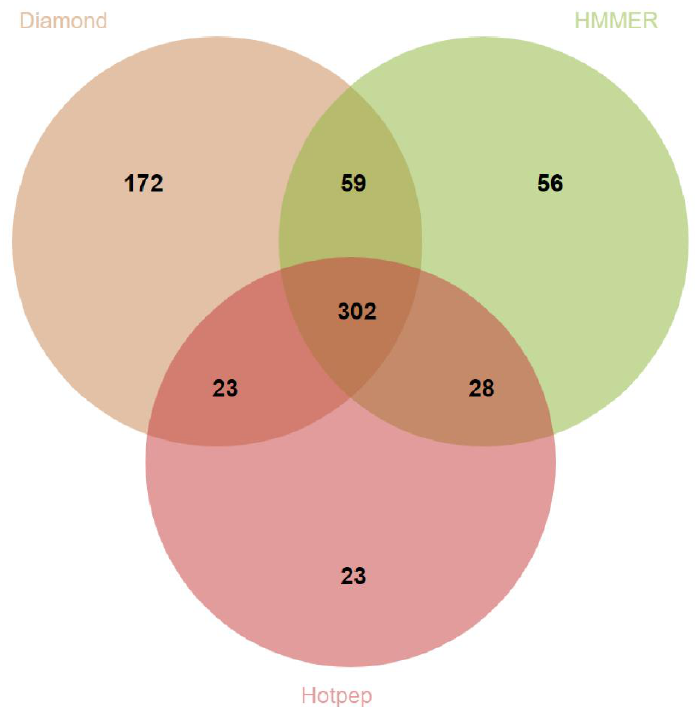
Figure 2. Venn diagram showing overlaps among the annotation results in T. hamatum FBL 587 for multi-domain CAZymes of three different tools: (1) HMMER, (2) DIAMOND, (3) Hotpep (see text). With respect to genes involved in the formation of SMs, a class of genes of relevance to mycoremediation, in FBL 587 a genomic repository of potential SMs driven by non- ribosomal peptide synthases (NRPS), polyketide synthases (PKS), hybrids NRPS-PKS and terpene was surveyed. Using the tool antiSMASH, version 6.0.0 (see [29]), we identified a relatively few number (27) of candidate BGCs for the production of SMs in T. hamatum FBL 587 (Table 2; Supplementary Table S6). Most of the antiSMASH-6.0-detected gene clusters cannot be annotated as their composition is not similar to any known fungal BGC (Supplementary Table S6). In T. hamatum FBL 587, we identified 8 PKS, 4 NRPS, 4 NRPS-PKS hybrids, and 6 terpene gene clusters (Table 2). The SM gene clusters found in the other Trichoderma species included in the paper for the antiSMASH-6.0 based-analysis are reported in Table 2 and Supplementary Tables S7–S11. Table 2. The identification and characterization of PKS, NRPS, PKS-NRPS hybrids and terpene gene clusters in T. hamatum FBL587 and other four Trichoderma species of the section Trichoderma (see [15]) performed with antiSMASH v. 6.0.0 (see [29]). The genome of T. lixii MUT3171 [4] of the clade Harzianum / Virens (see [15]) is included in the antiSMASH-6.0 analysis, as it was chosen to represent the outgroup species. All Trichoderma genome sequences were taken from NCBI databases and have been published [4,14,15,34,35]. Genome assemblies are available at DDBJ/EMBL/GenBank under the